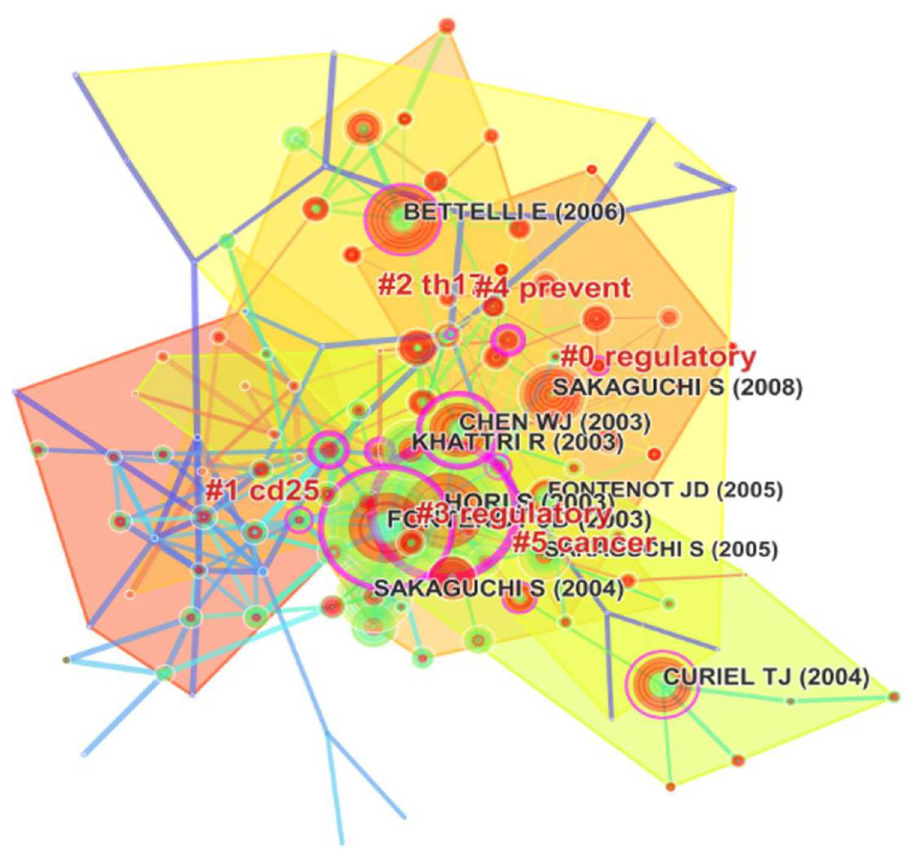
Fig 6. Reference co-citation map of articlesrelatedto regulatoryT cell (Treg) research publishedfrom 2000 to